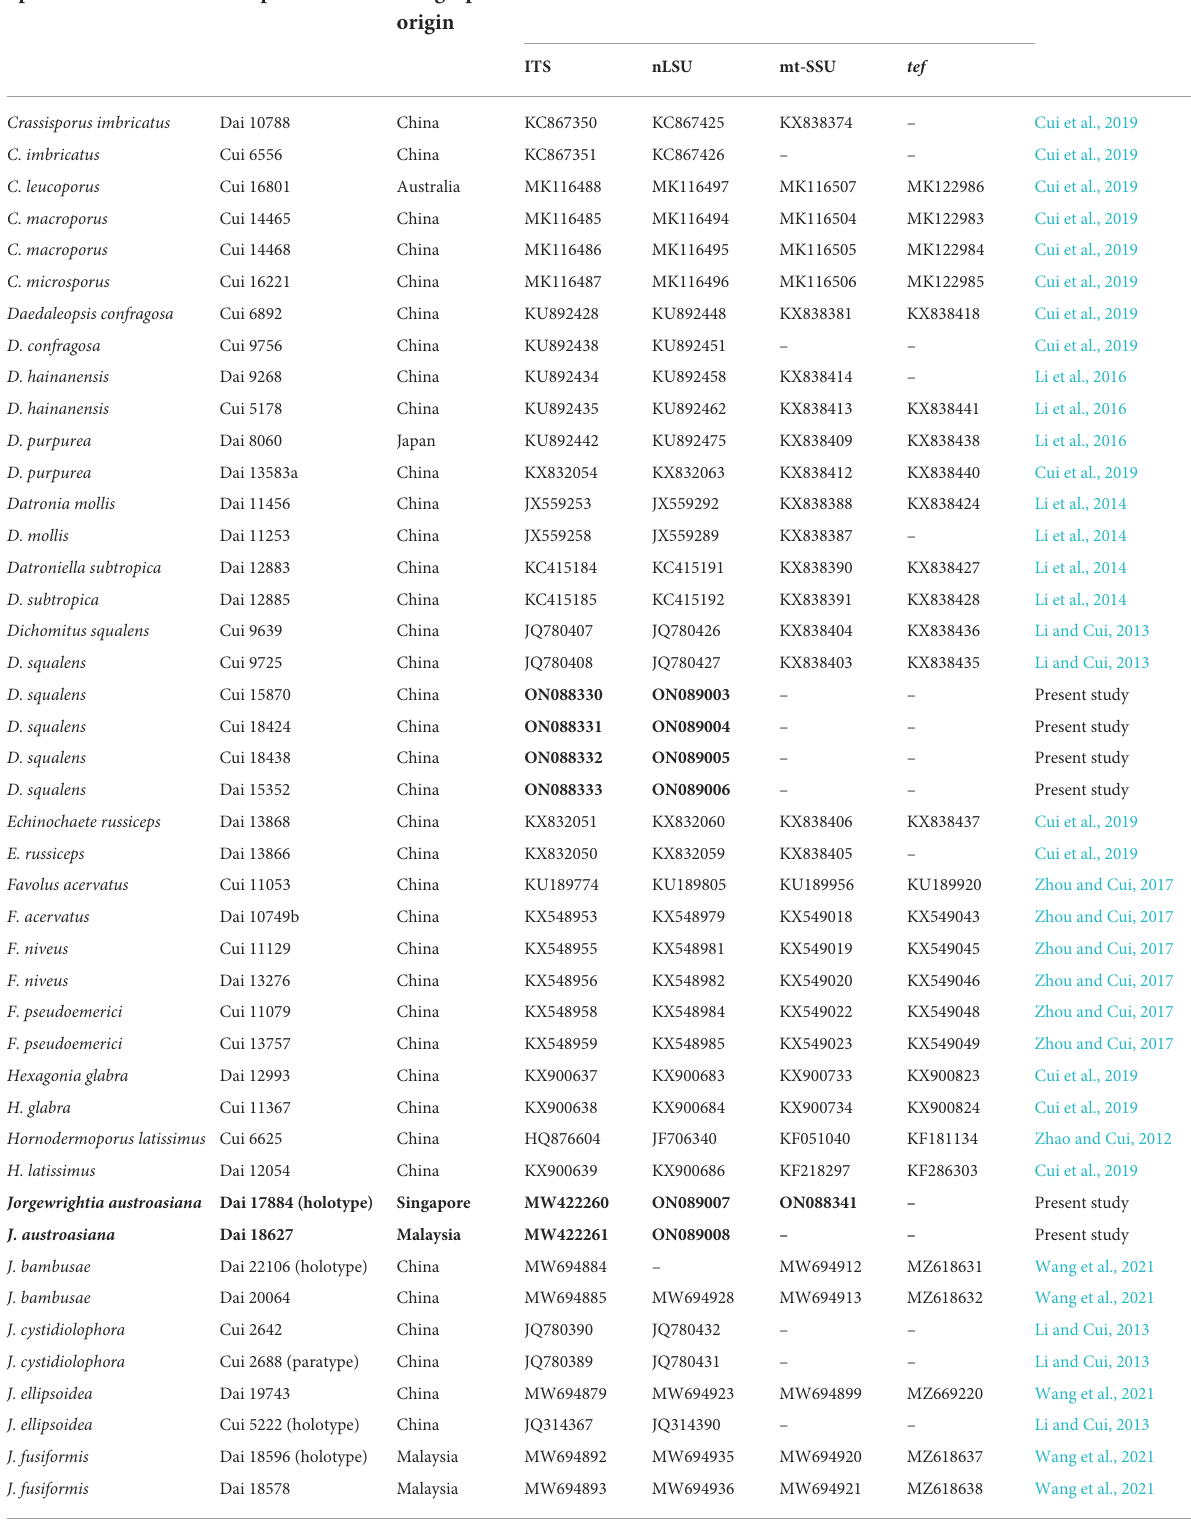
TABLE 1 Taxa information and GenBank accession numbers of the sequences used in this study.